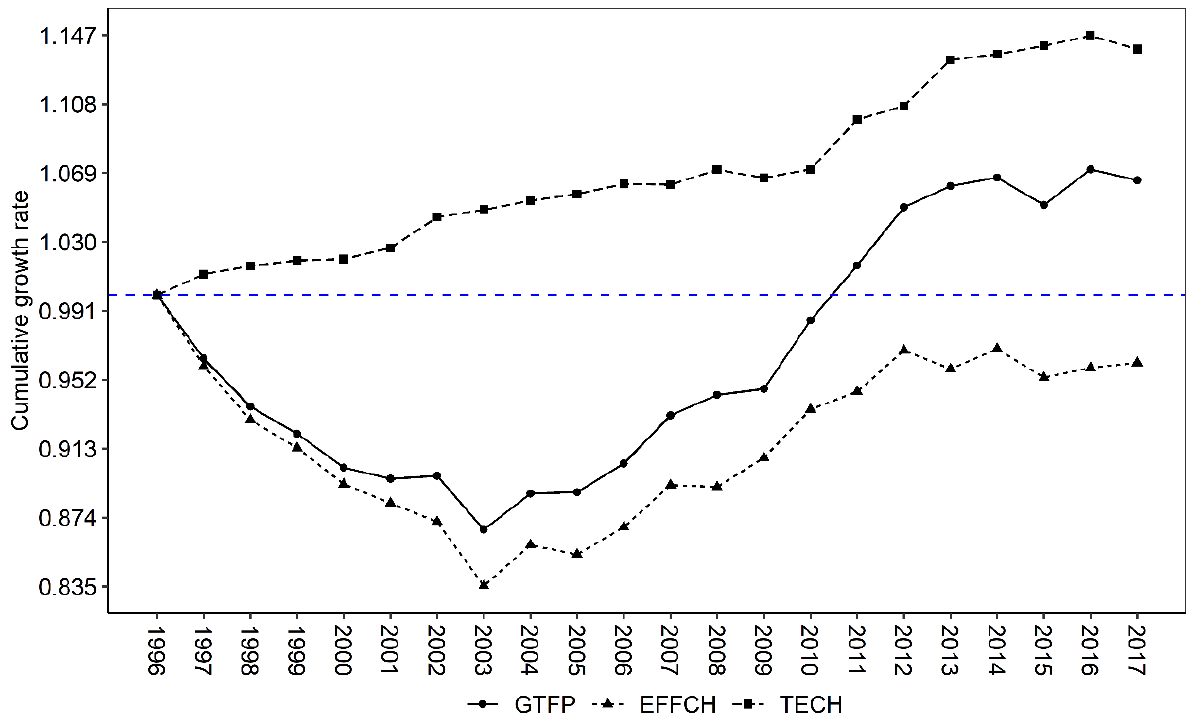
Figure 3. Cumulative change in average GTFP, EFFCH and TECH, 1996–2017. The blue dash line denotes 0 value horizontal line.